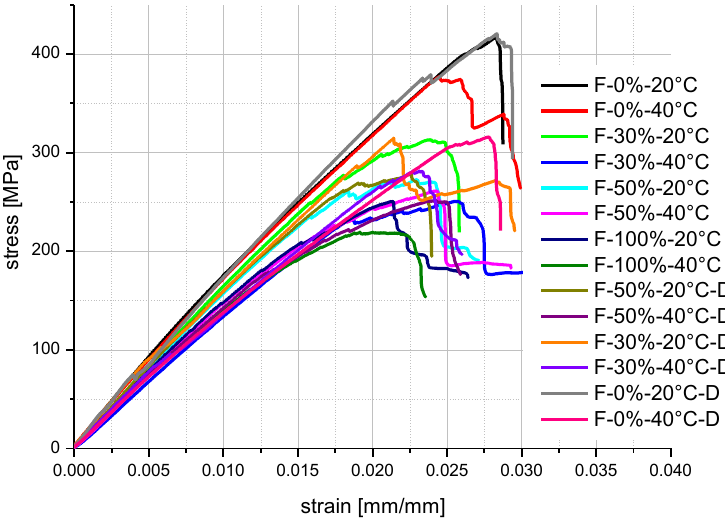
Figure 7. Stress-strain curves of FRP specimens under flexural tests.